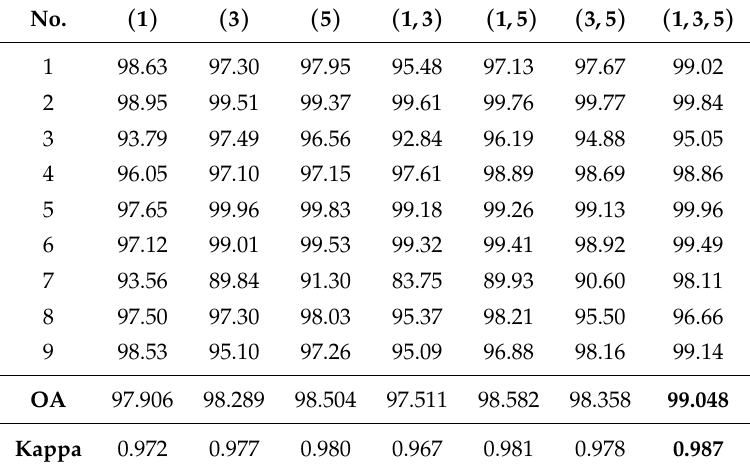
Table 6. Class-specific accuracy (%), OA (%) and Kappa coefficient generate by the ASSP-SCNNs on PaviaU dataset. Here we equip ASSP-SCNN with seven different ASSP layer with